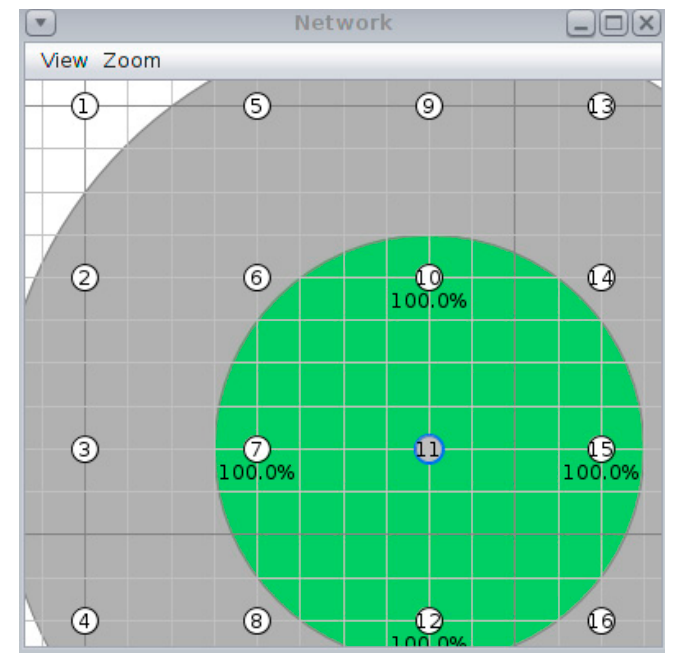
Figure 8. Physical topology for all simulations.